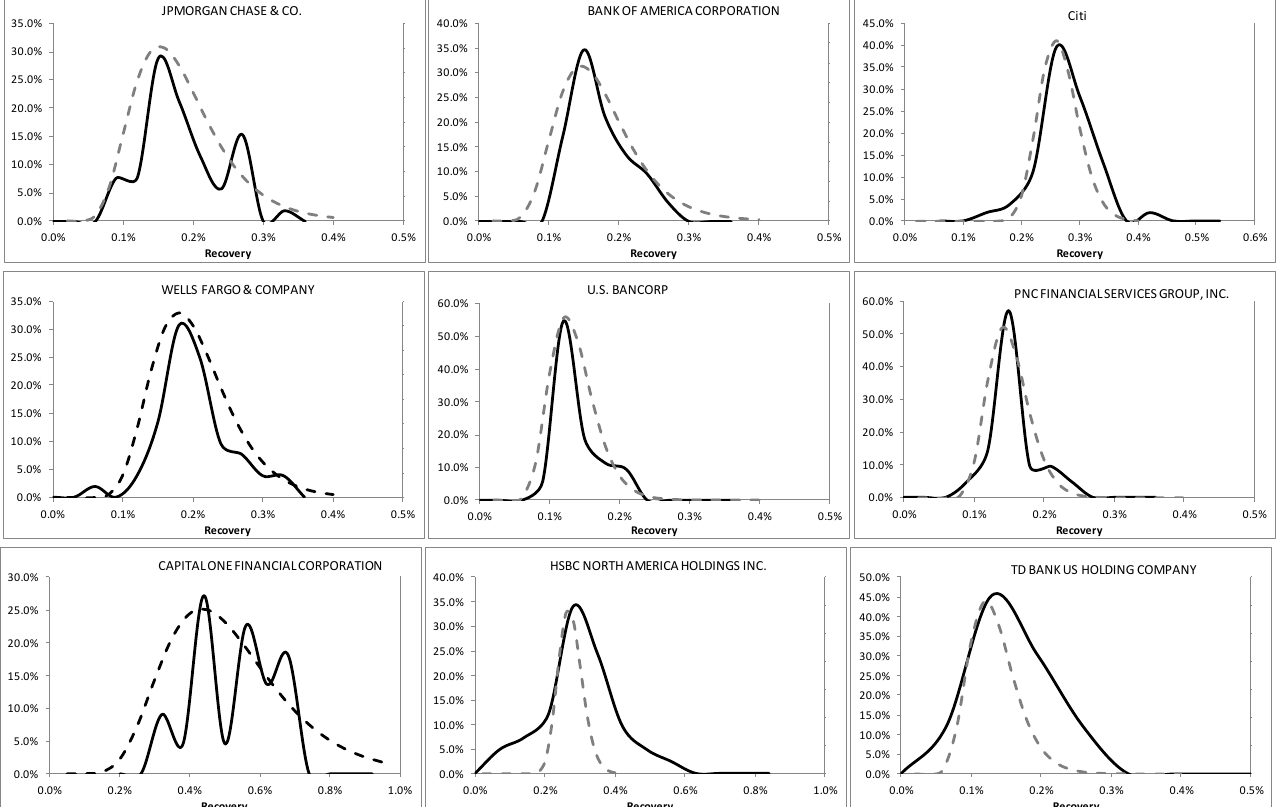
Figure 4. Distribution functions of recovery ratios (recoveries/portfolio value). Source: Author’s work.